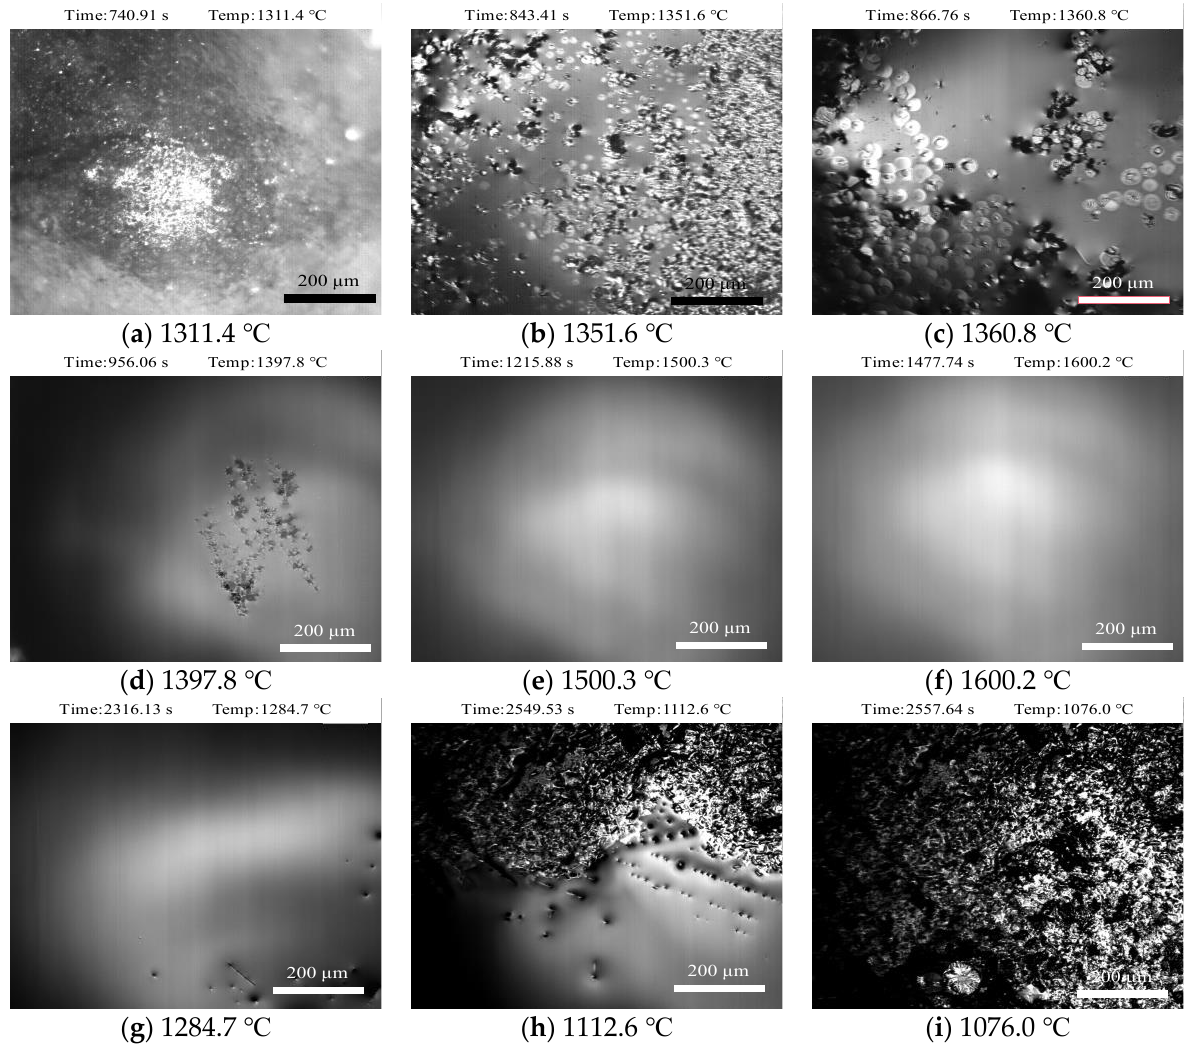
Figure 5. Heating and cooling processes of slag under a high-temperature confocal microscope.